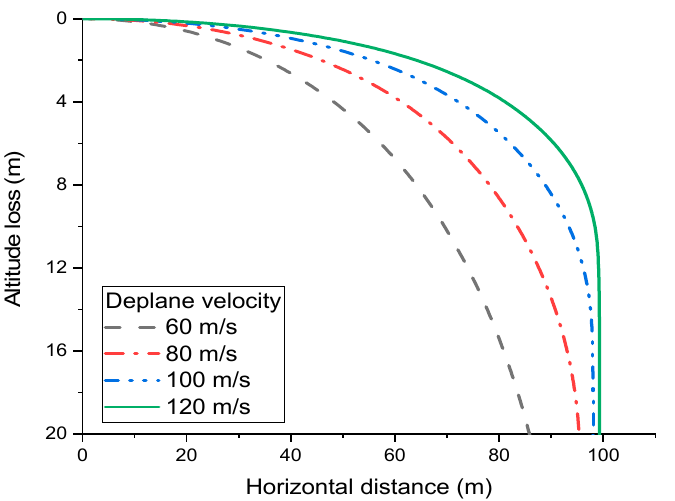
Figure 8. Flight trajectories of parachute airborne systems at different deplaning velocities.